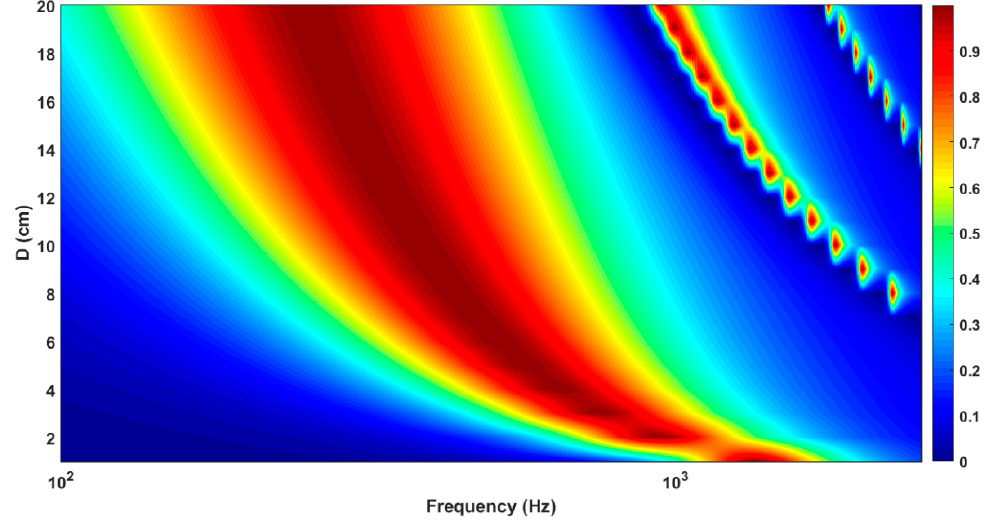
Figure 9. Absorption coefficient of an SL-MPP as a function of ( f , D ) for ( d , t , ) = (0.4 mm,1 mm, 1%).